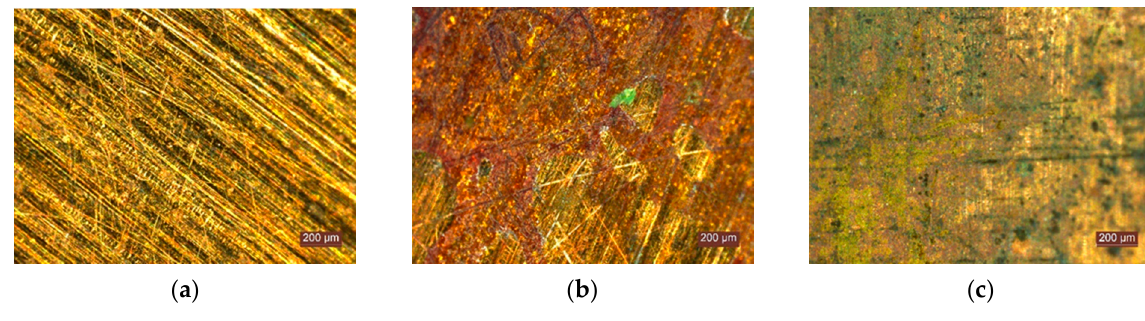
Figure 9. Evolution of the appearance of metallic Cu: ( a ) initial appearance of the metal specimen; ( b ) appearance of the metal specimen after testing; ( c ) appearance of the metal specimen after testing and washing of corrosion products.